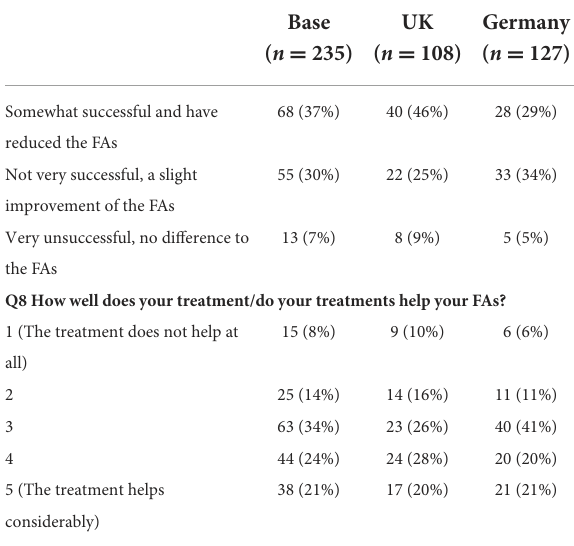
TABLE 1 Data subjects’ responses to sample characteristics (Q1–Q8 of